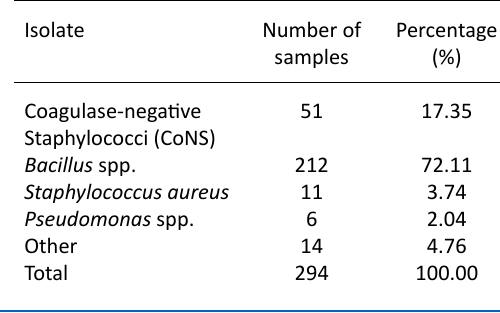
table 2. Various bacterial isolates from surface